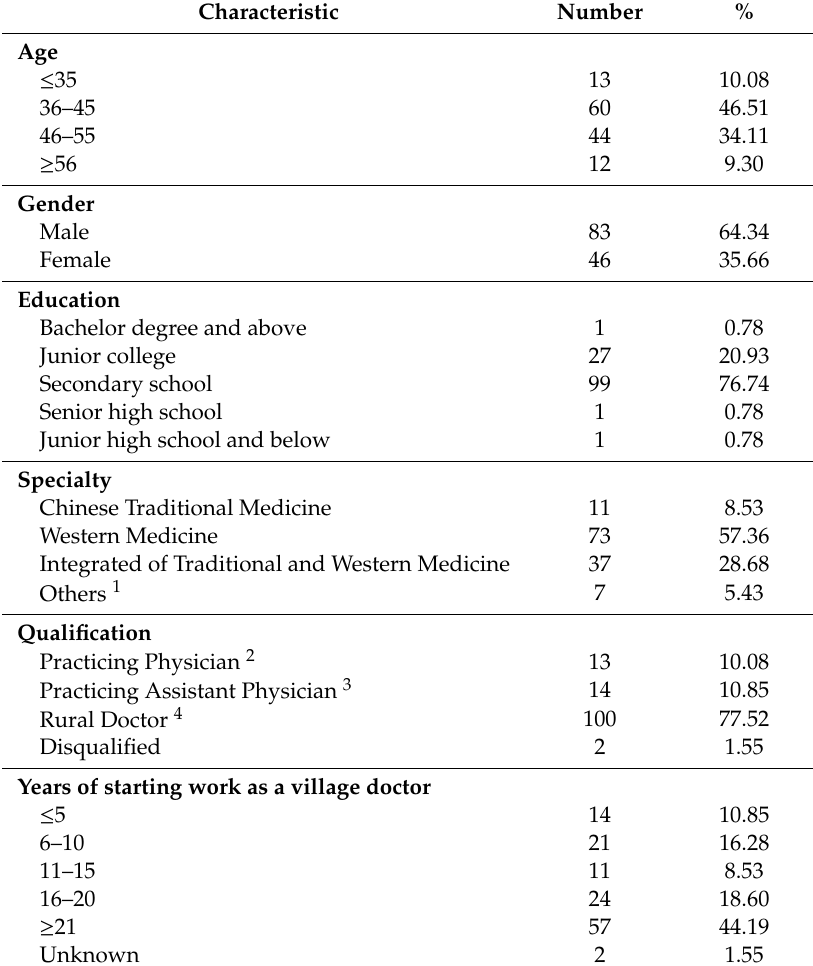
Table 1. Village doctors’ demographics ( n =